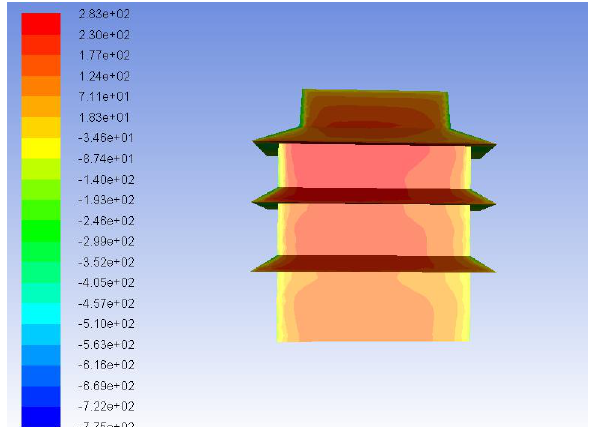
Figure 14. The wind pressure distribution of Guanghua Pavilion [ 光化楼 ]